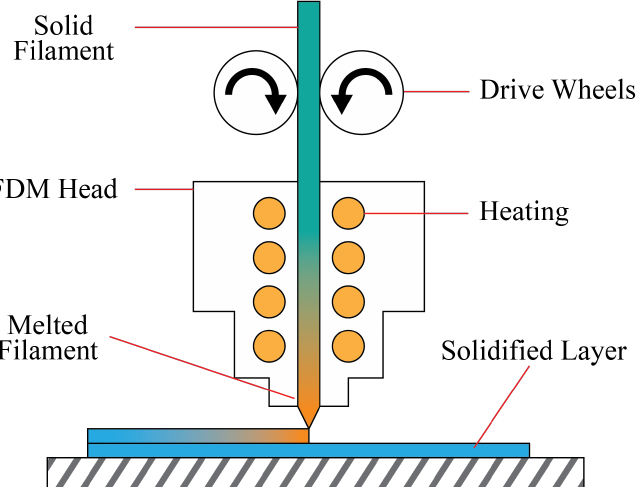
Figure 3. In printing using an FDM printer, drive wheels push a solid filament for the FDM head to melt and extrude the